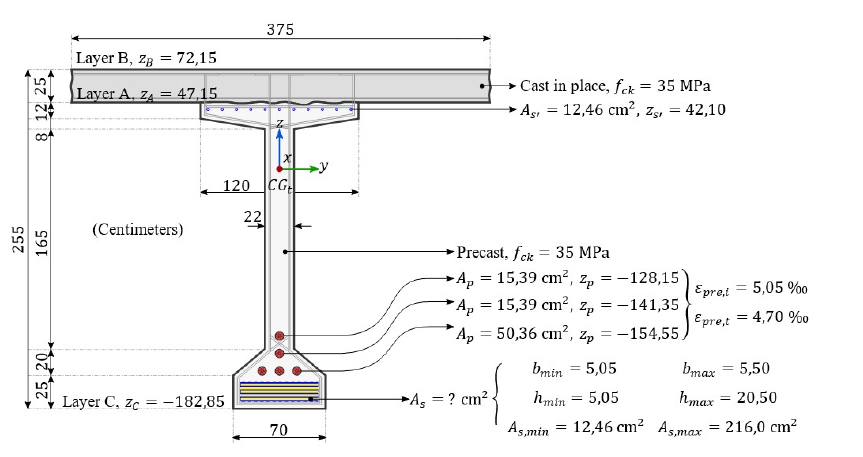
Figure 16. Proposed beam for numerical